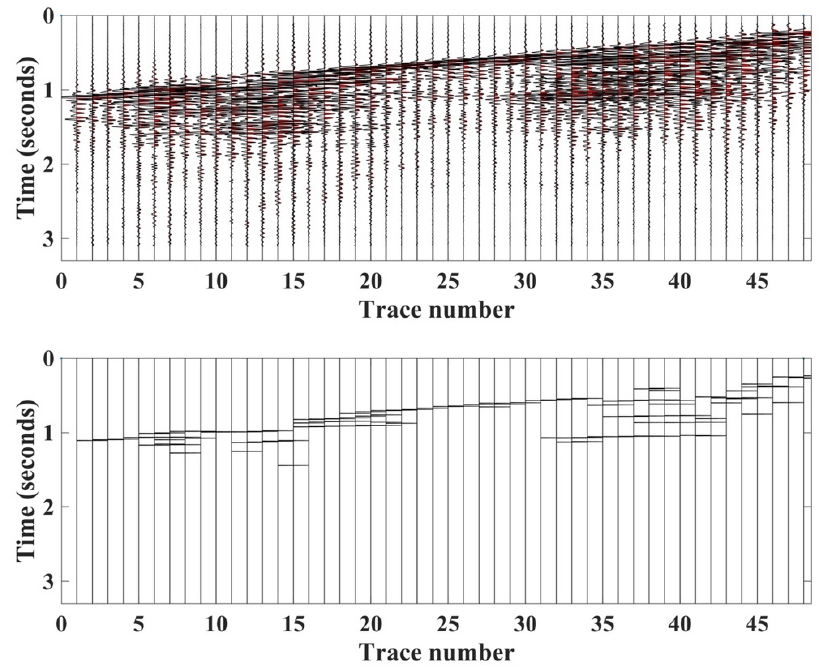
Figure 10. Yilmaz record number 22 ( top ) and picks determined by the HEEH method ( bottom ).